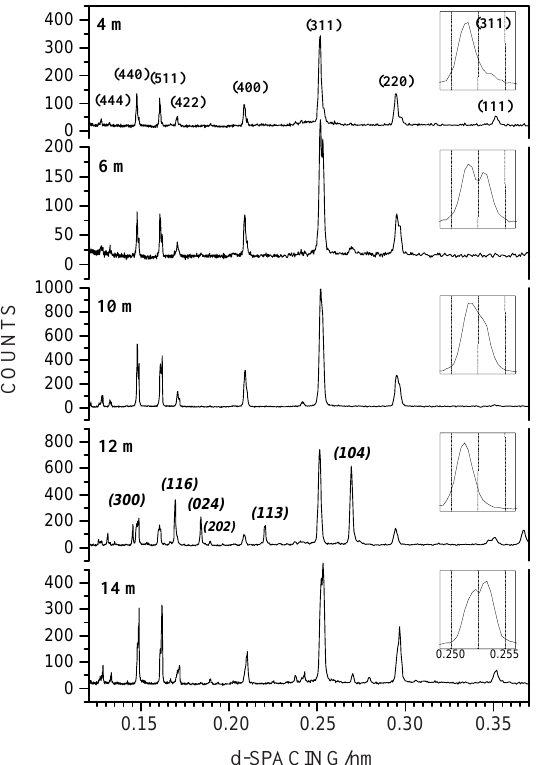
Figure 1. X-ray patterns of powdered crystals under analysis. Reflection planes of cubic iron-spinel are indicated for the 4 m sample and of the hematite for the 12 m sample (in italics). Inset: a magnified d-spacing scale view of the (311) reflection of the spinel phase is presented for each sample.